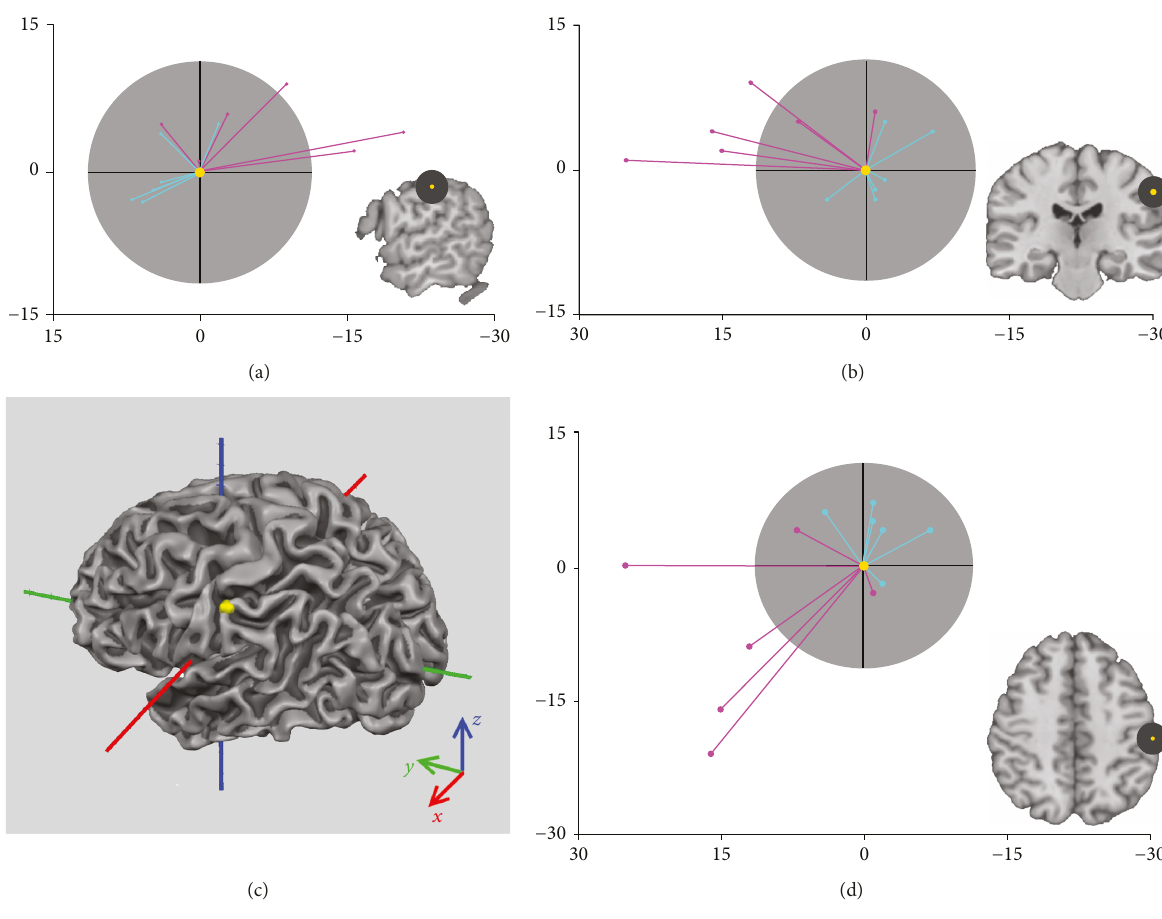
Figure 3: S1 dislocation vectors of each patient for the gentle tactile stimulation of both nondominant (pink vectors) and dominant (cyan vectors) hands, projected in sagittal (a), coronal (b), and axial (d) planes. The yellow point represents the position of S1 resulting from the group analysis ( x = − 57, y = − 17, z = 44 ) and is set to zero. The sphere of expected localization ( < 1.5 standard deviation (SD)) in control brains (grey) has radius r CG =11.5mm. Color code of axis respects the convention [ x , y , z ] → RGB ( x =red, y =green, z =blue). Axis scales are in millimeters. In the bottom-left corner (c), the three dimensional representation of S1 control group ROI (yellow) is overlapped on the mesh of the white/grey matter boundary of a standard brain (Colin27 brain, [24]). All dominant hand vectors are within a 1.5 SD, as well as 2 out of 6 hemiplegic subjects. Not the posterior-mesial gradient for S1 Figure 4(a). Mean dislocation indices of the nondominant hand and the dominant hand in hemiplegic subjects resulted signi fi cantly di ff erent ( p < 0 05 ).